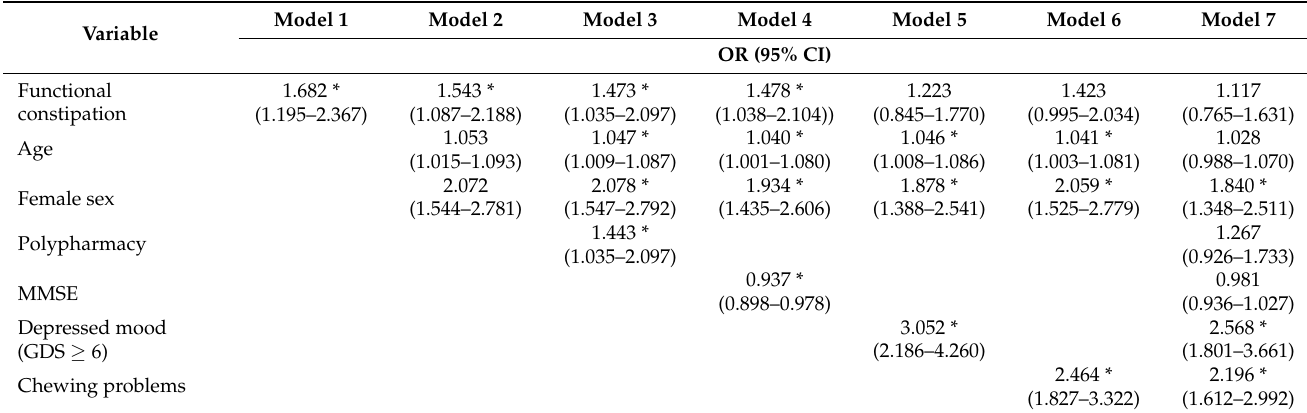
Table 2. Association between functional constipation and anorexia of